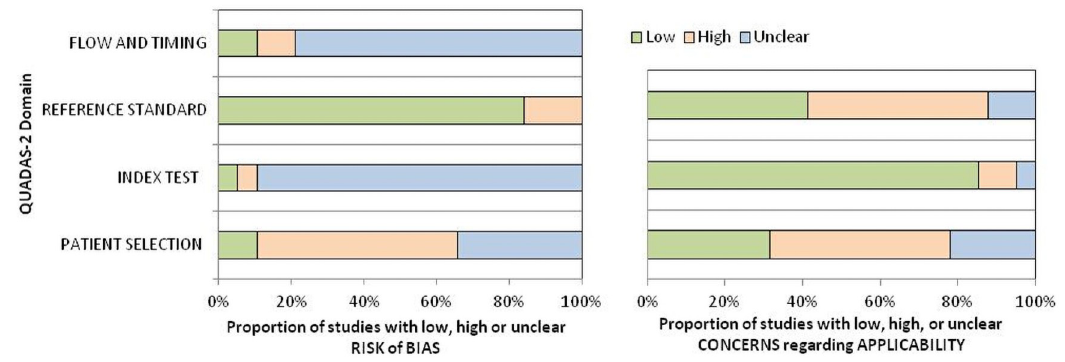
Fig 7. Risk of bias assessed by the QUADAS-2 tool according to different study characteristics (patient selection, index test, reference standard and flow and timing).